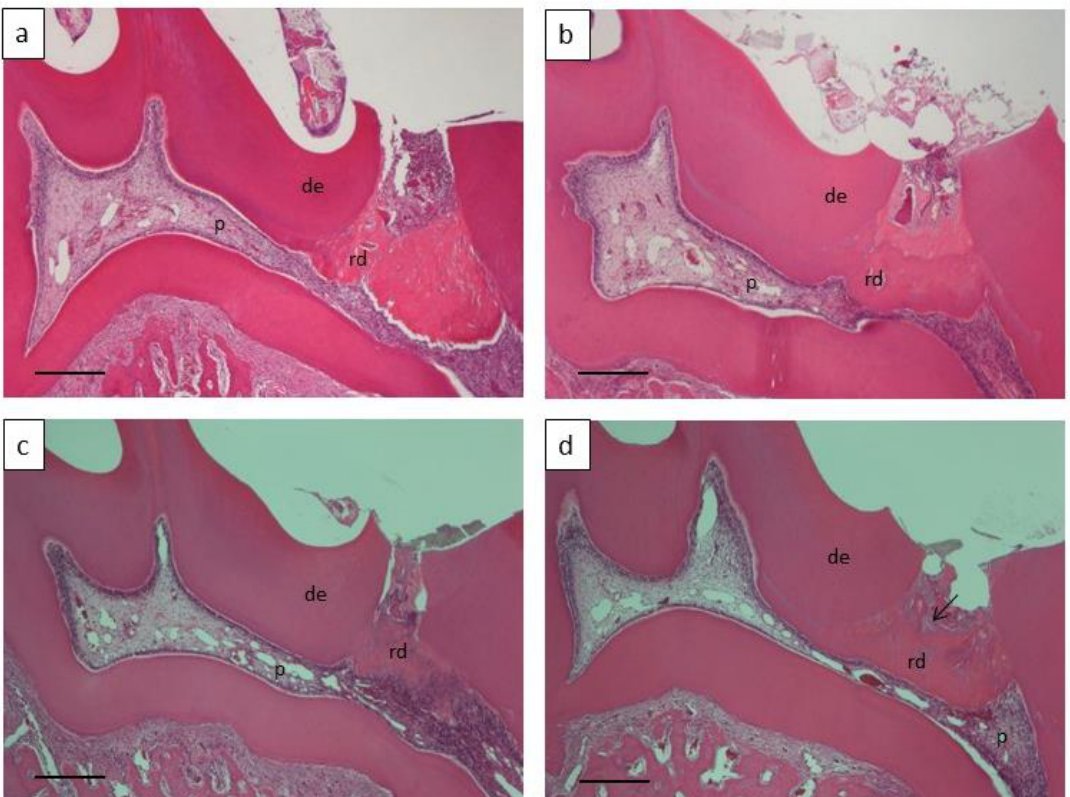
Figure 3. Histological observation of the formed reparative dentin ( n = 4) treated with ( a , b ) the DPP-derived RGD-containing peptide and calcium hydroxide ( c , d ). Bar = 150 µ m, de: dentin, p: pulp, rd: reparative dentin, arrow: defect.